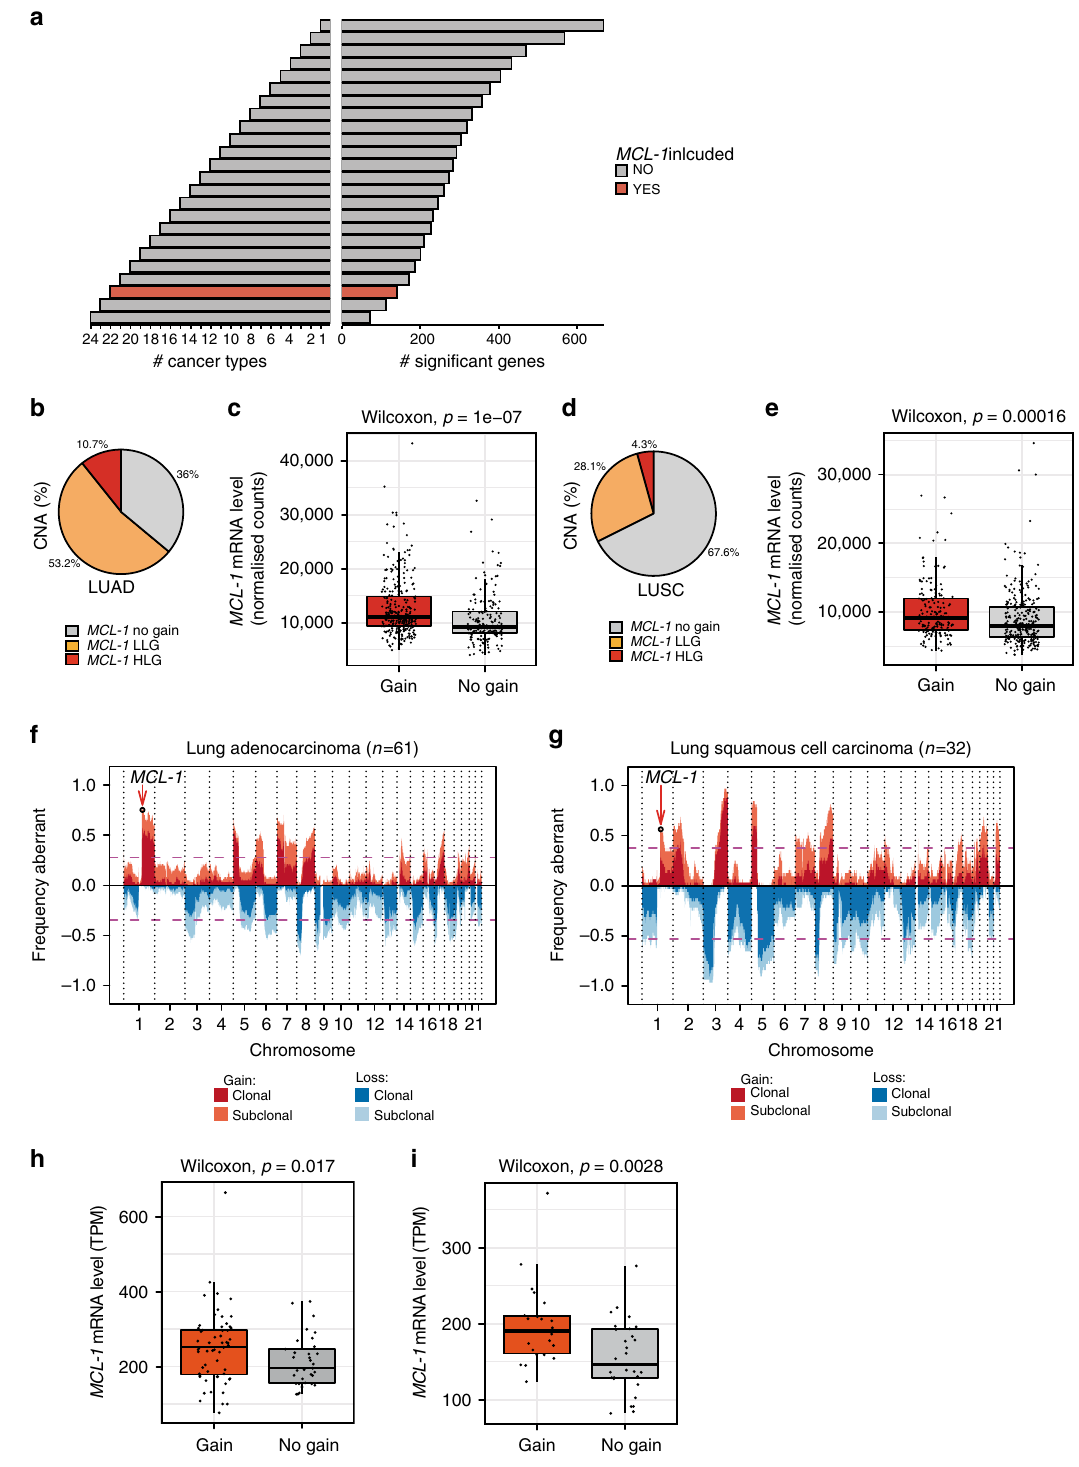
To con fi rm MCL-1 genomic gains in a different cohort, we used fl uorescence in situ hybridisation (FISH) with MCL-1 probes on two tissue microarrays (TMA) of 56 and 24 primary human LUAD tissue samples. FISH analysis revealed polysomies of chromosome 1q21 and high- and low-level gain of MCL-1 in 48.8% of the samples (Fig. 3a, b). We analysed MCL-1 protein levels in the second TMA, detecting a strong staining intensity for 10 out of 25 (40%) samples and an intermediate staining intensity